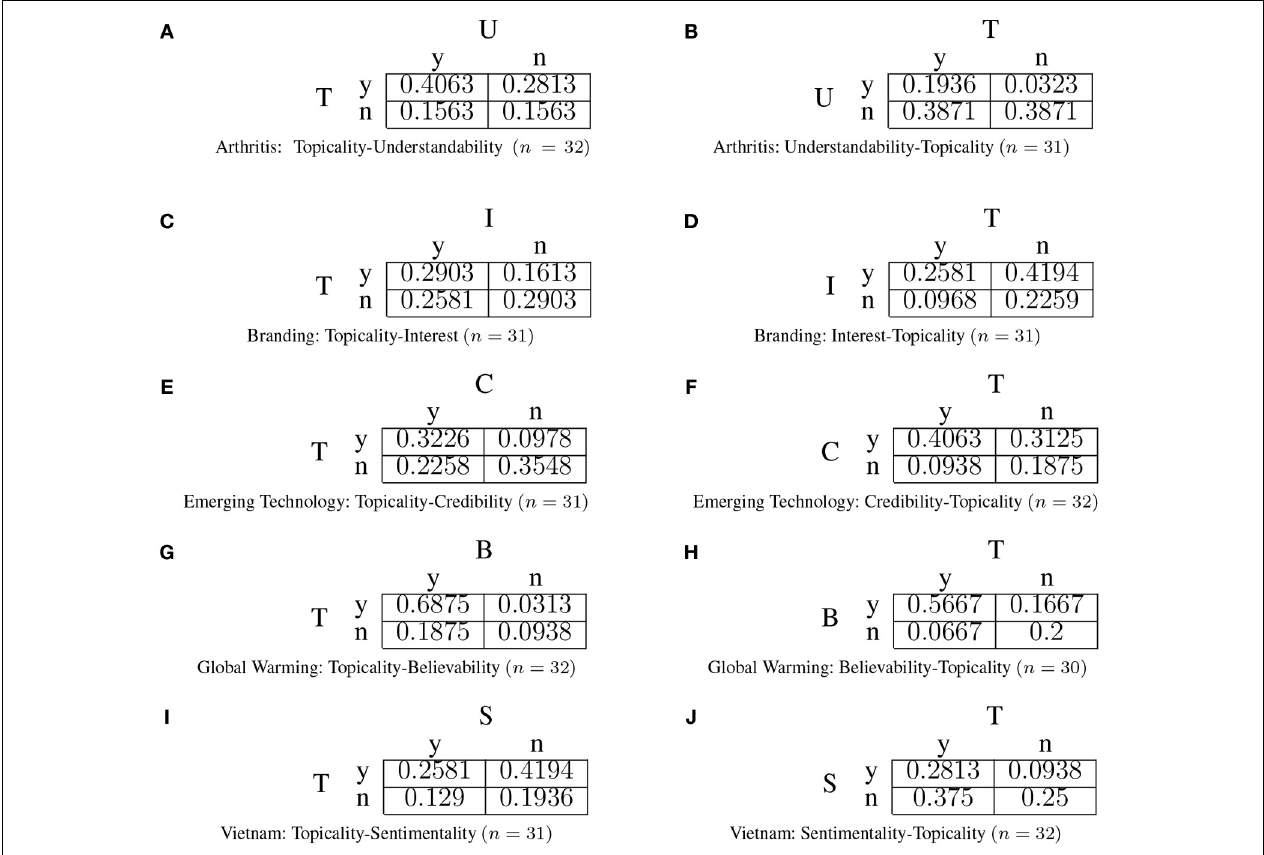
FIGURE 4 | Yes/no contingency tables from “normal” turkers. The left hand side represents the condition where topicalilty is decided first (Non-comparative context for a decision on topicality). The right hand side represents the condition where topicality is decided second (Comparative context for a decision on